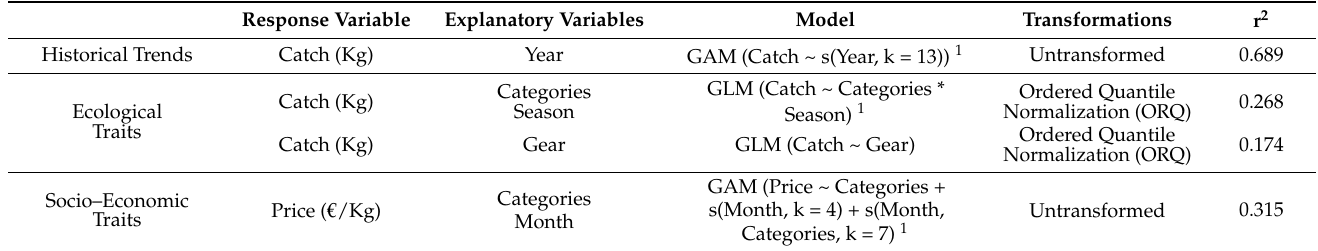
Table 1. Summary of models performed and their statistics. Respective response variables, potential transformations and explanatory variables used for each